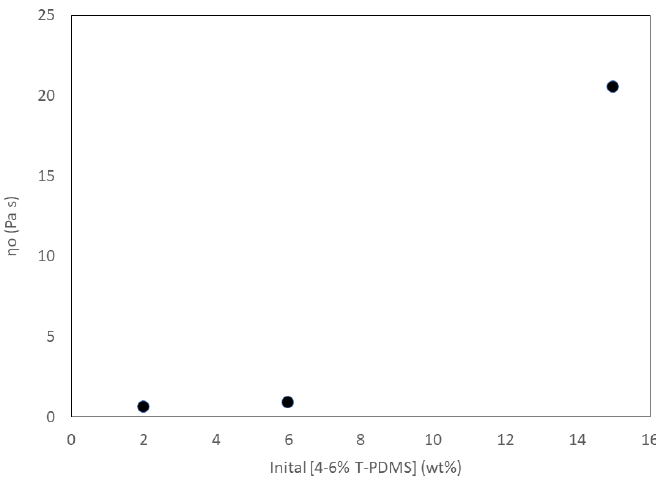
Figure 7. Plot of the zero-shear viscosities ( η 0 ) of liquid 4–6% D-PDMSs versus initial 4–6% T-PDMS concentrations.